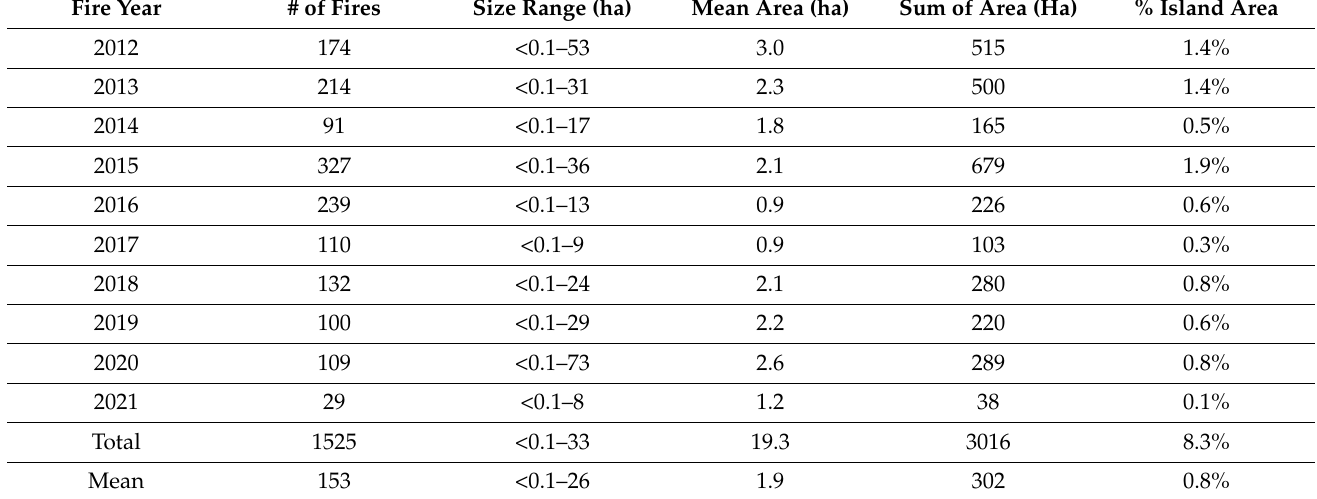
Table 3. Number, percentage, mean area (ha), sum of area (ha) and % of total area of wildfires inside and within 50 m of protected areas (PA’s) on Babeldaob Island, Palau, per year from 2012 to 2021.